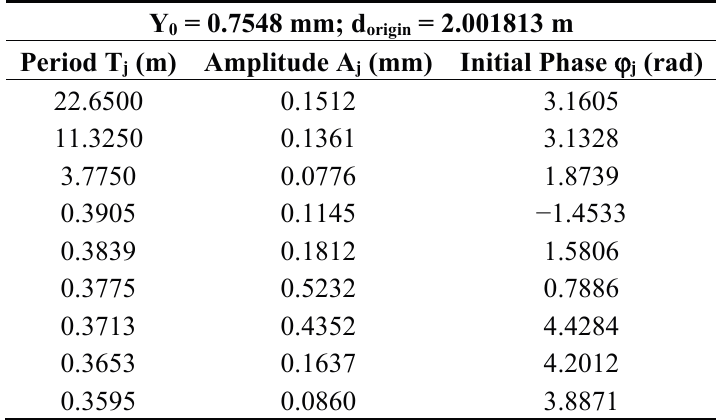
Table 11. Parameters of the correction function–Trimble S6.